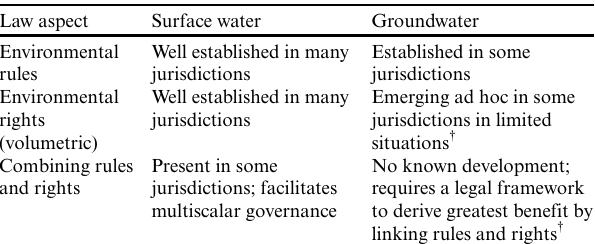
Table 1. Environmental rules and rights for surface water and groundwater: status and